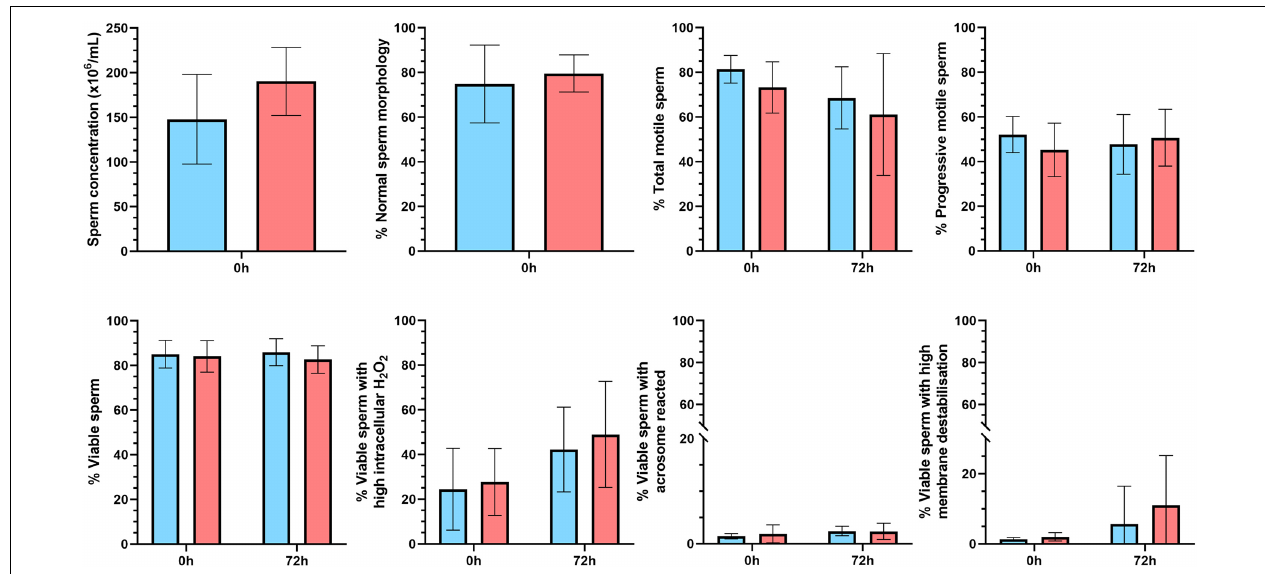
FIGURE 4 | Sperm quality and functionality parameters upon semen collection (0 h) and after 72 h of liquid storage at 17 ◦ C in two groups ejaculates clustered on the basis of AKR1B1 concentration in seminal plasma (SP) samples. Fourteen ejaculates were classified into two groups: with low SP-AKR1B1 levels (ranging from 376.4 to 756.3 ng/mL, n = 7; blue bars) and with high SP-AKR1B1 levels (ranging from 842.2 to 1211.25 ng/mL, n = 7; red bars). Data are represented as mean ± standard error of the